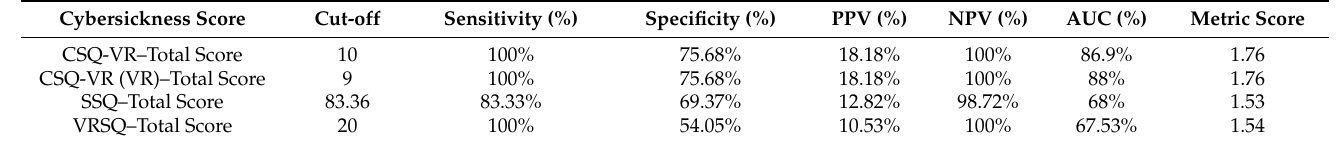
Table 6. Psychometric Properties of the CSQ-VR, SSQ, and VRSQ in detecting Motor Speed Decline. Cybersickness